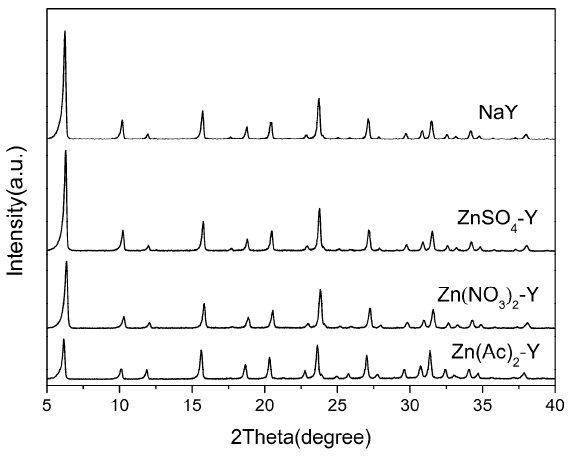
Figure 1. XRD patterns of different adsorbents.